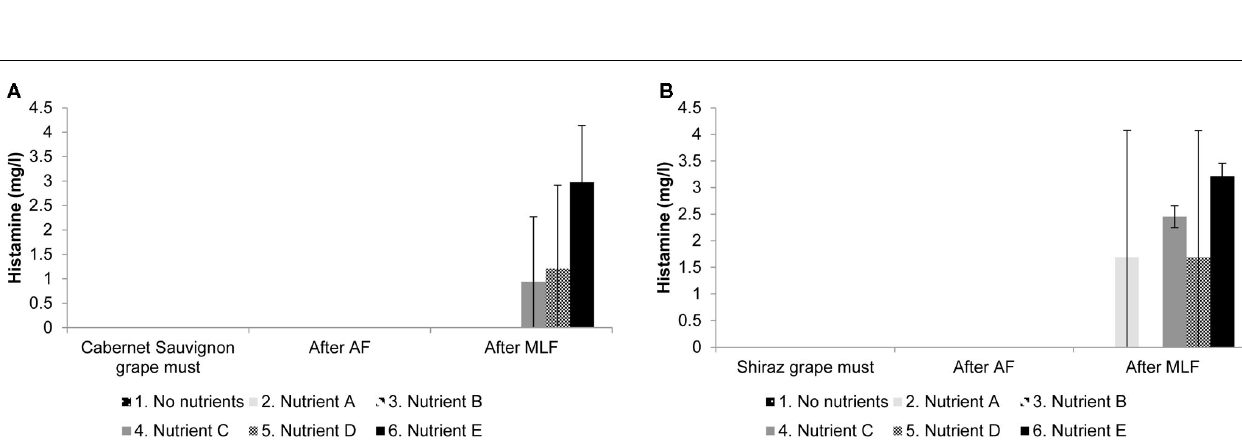
FIGURE 2 | Malolactic fermentation (MLF) (malic acid degradation) and growth of lactic acid bacteria in Shiraz wines. Results are the average of duplicate treatments. AF = alcoholic fermentation.